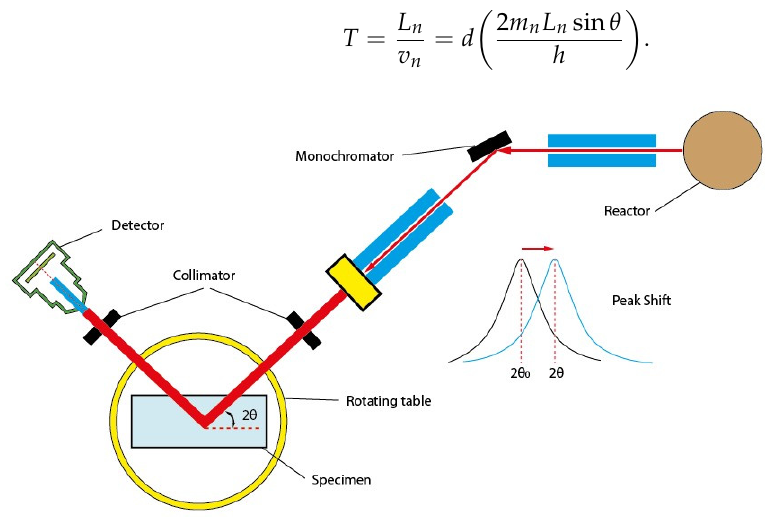
Figure 5. Schematic of monochromatic 2 θ scanning method.